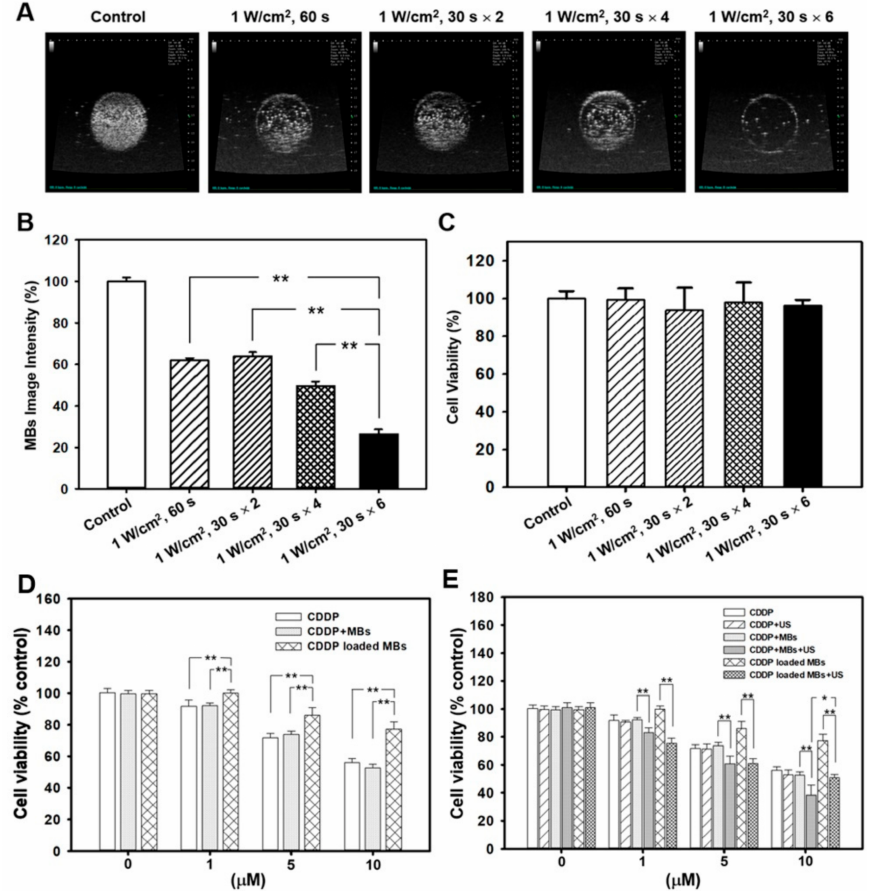
Figure 2. Destruction of ultrasound-targeted MBs and the comparison of in vitro CDDP toxicity on the FaDu cell line in various compositions of CDDP and MBs. ( A ) MB images and ( B ) the corresponding image intensities in various groups of acoustic exposure settings; ( C ) Percentage of cell viability evaluated by WST-1 analysis on FaDu cells 48 h after various ultrasound-targeted MB destruction treatments; ( D ) Cell viability was assayed by WST-1 after treatment with CDDP, CDDP + MBs, and CDDP-MBs for 48 h; ( E ) The capacity of the CDDP only, CDDP + MBs, and CDDP-MBs treatments to kill FaDu cells, with or without ultrasound exposure, was evaluated after 48 h of treatment by analyzing the cell viability using the WST-1 assay. Values are expressed as mean ± SEM ( n = 5). * p < 0.05, ** p <